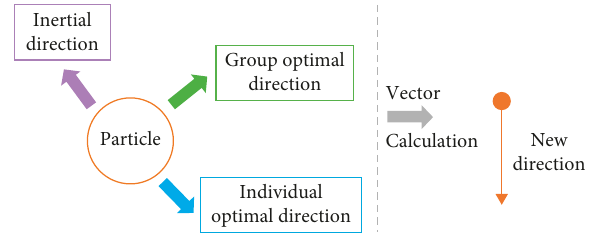
Figure 2: New direction of particle